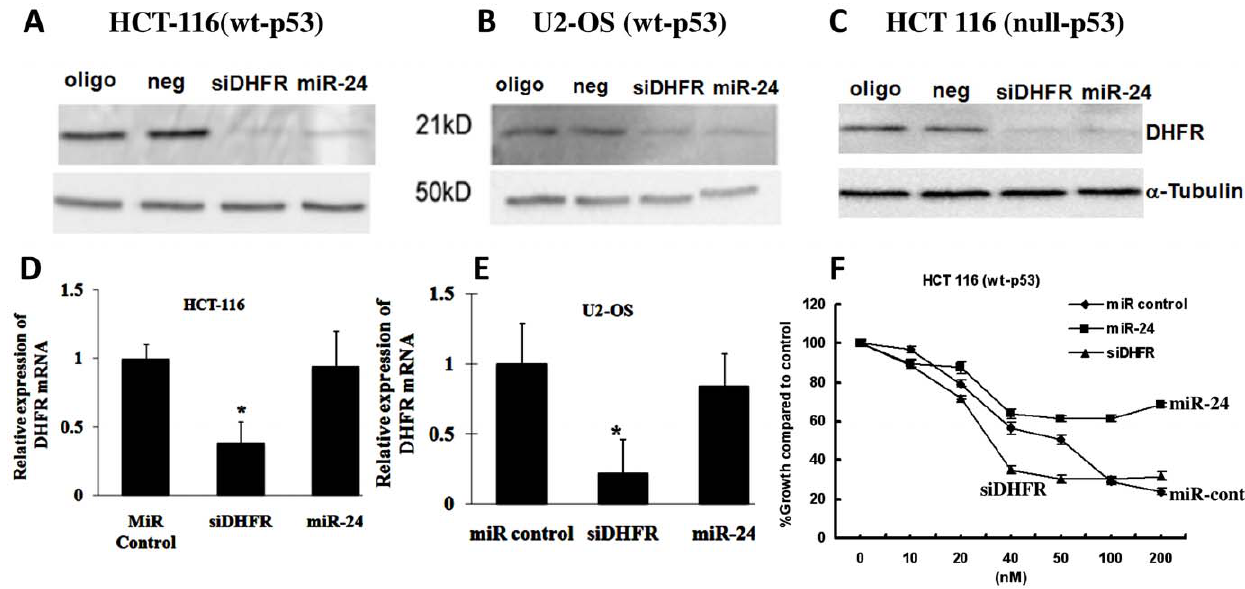
Figure 3. MiR-24 regulates cell proliferation by regulating DHFR levels, independent of p53 status. (A–C) miR-24 over-expression down- regulated DHFR protein levels in three cancer cell lines independent of p53 function; in colon cancer HCT 116 (wt-p53) (A), osteosarcoma cell line U2- OS (wt-p53) (B), and HCT-116 (null-p53) cancer cell lines (C). Oligofectamine alone (oligo) and non-specific miRNA (neg) were used as the negative controls. siRNA specific against DHFR (siDHFR) was the positive control. (D–E) The levels of DHFR mRNA in HCT-116 and U-2 OS cells were determined by real time qRT-PCR analysis, GAPDH was used as an internal standard for normalization (data are shown as mean 6 SD. *, P , 0.05). (F) miR-24 not only inhibited cell growth but also induced MTX resistance in a HCT-116 colorectal cancer cell